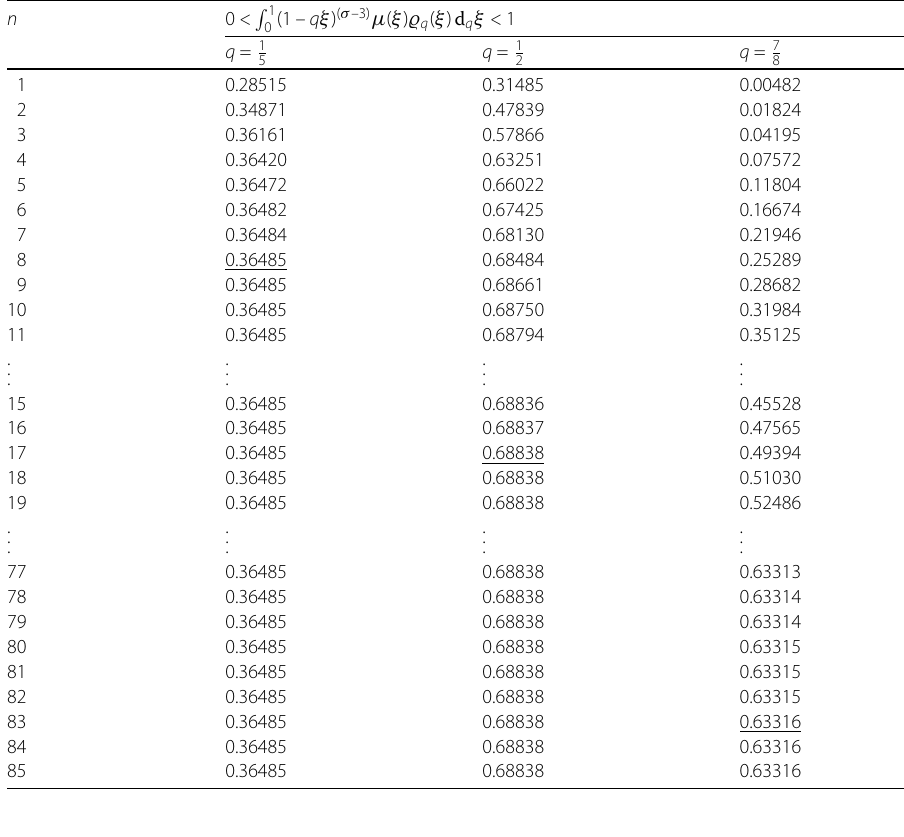
Table 6 Numerical results of q = 1 , 1 , 7 in Example 5 2 8